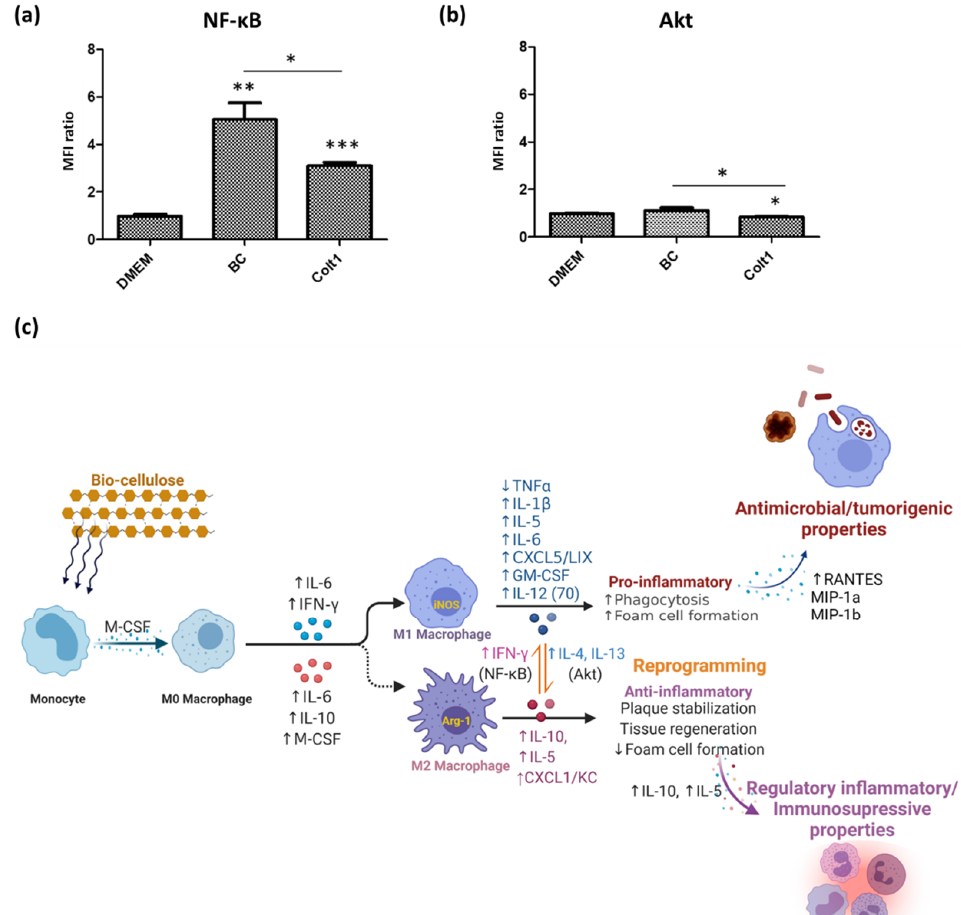
Figure 10. Signaling pathways alteration in macrophages affected by bacterial cellulose (BC) scaffold after 24 h of treatment. ( a ) Nuclear factor kappa B (NF-κB). ( b ) Protein kinase B (Akt). ( c ) Summary of macrophage polarization states (this figure was created with BioRender.com and based on icons from biorender.com). (* p < 0.05; ** p < 0.01; *** p < 0.001) .